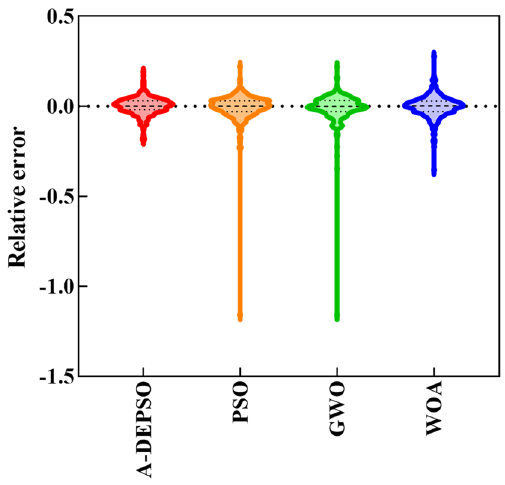
Figure 18. Relative errors calculated by all hybrid